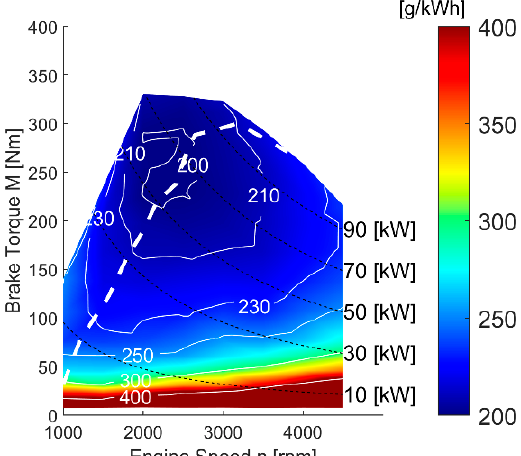
Figure 3. Engine map with the iso-BSFC lines and the minimum BSFC line (white dotted line).